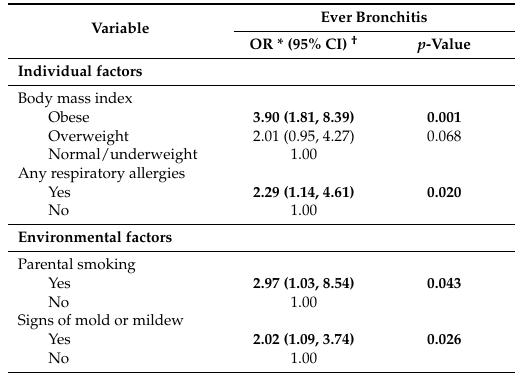
Table 2. Adjusted odds ratio for the relationship between risk factors and ever bronchitis.